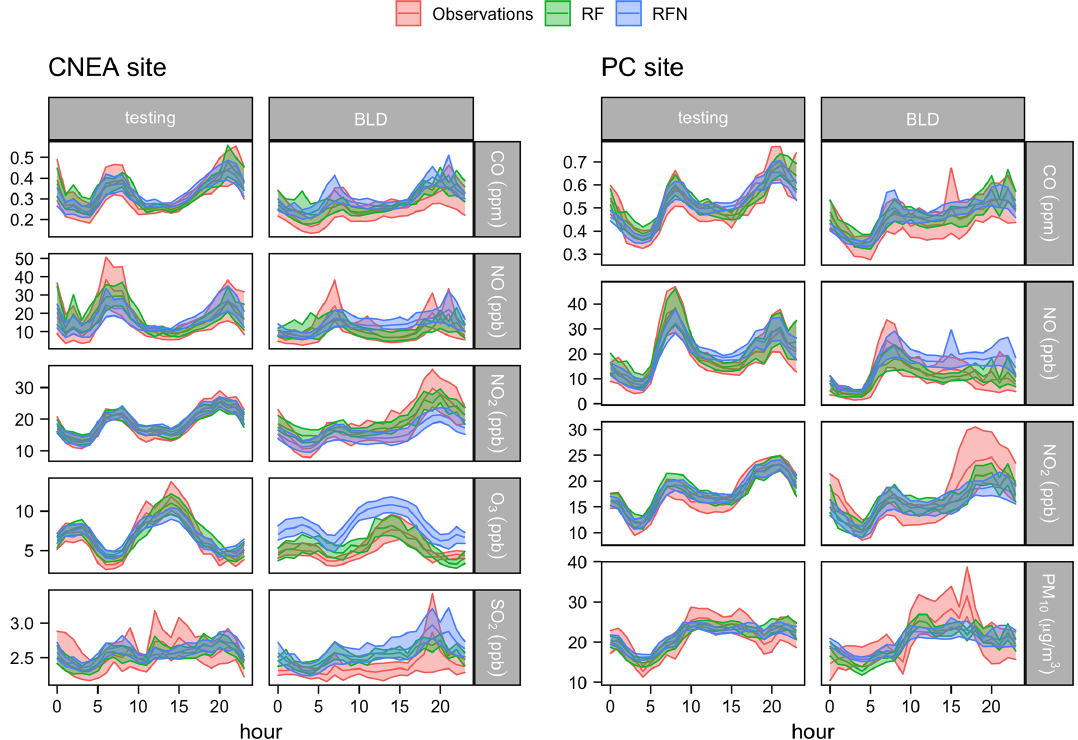
Figure 3. Mean diurnal cycles for the testing dataset and for the evaluation period (BLD). The line represents the average diurnal cycle, and the shaded area represents the standard deviation.